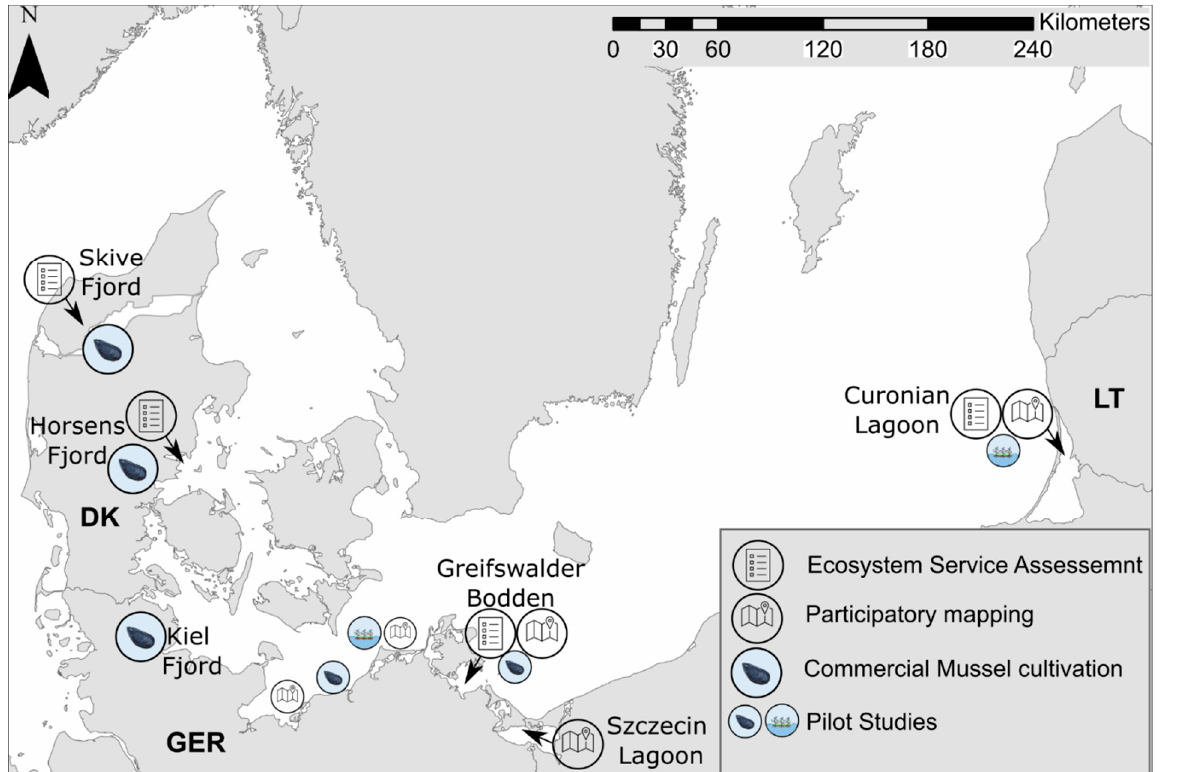
Figure 1. Overview of the study area. The different pictograms show in which countries ecosystem service assessments and participatory mappings were conducted. Furthermore, they indicate which countries already have experience with ecological measures like mussel cultivation or floating wetlands. Table 1. Overview of workshops in which the participatory mapping approach was applied.